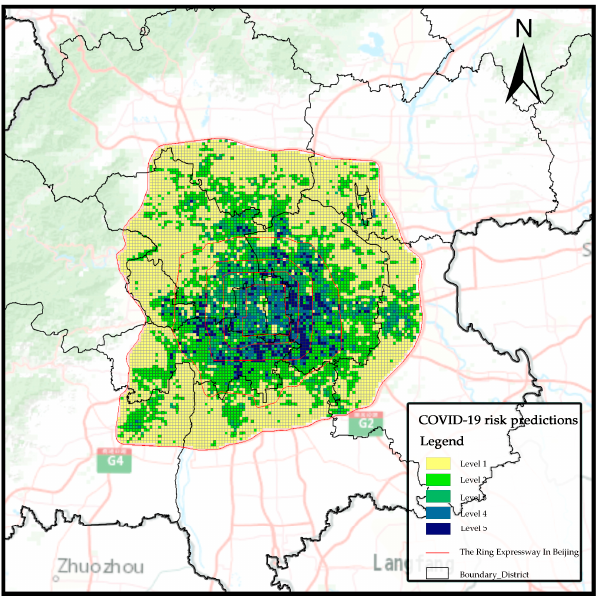
Figure 8. This is a figure. Schemes follow the same